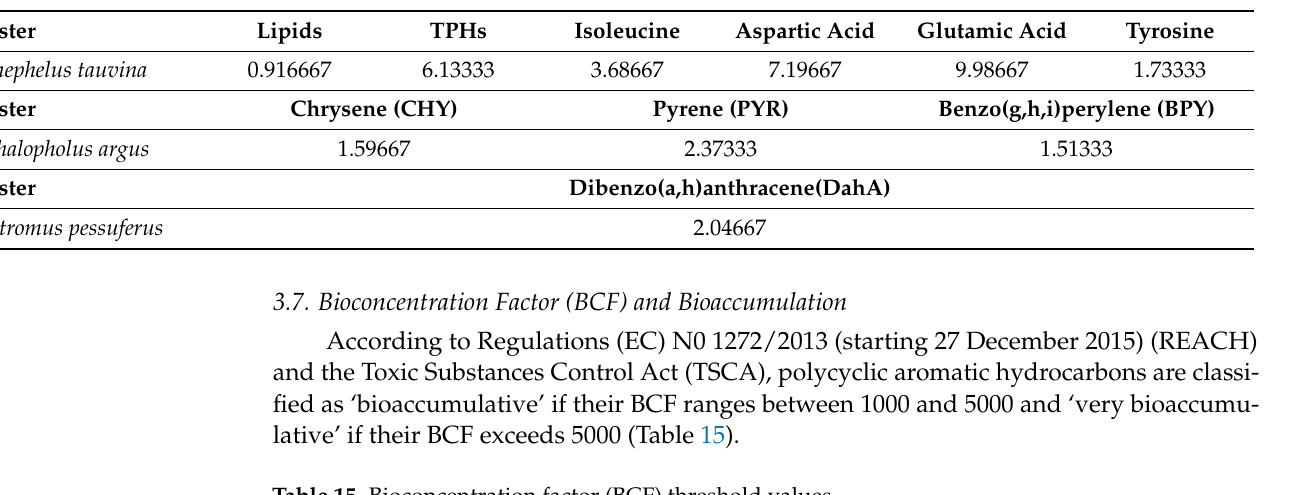
Table 15. Bioconcentration factor (BCF) threshold